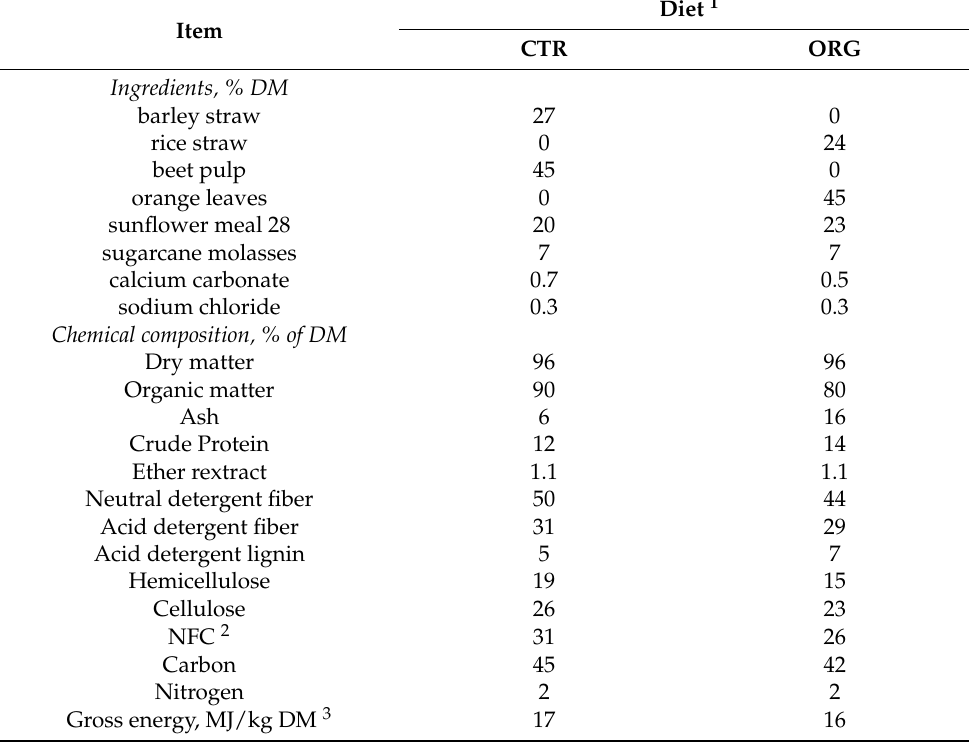
Table 1. Ingredients and chemical composition of